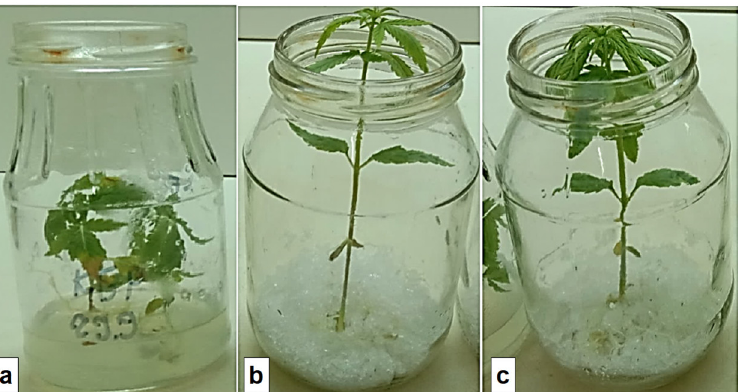
Figure 5. Visualization of the first cultivation cycle of Cánnabis satíva (14 days) on: ( a ) agar substrate; ( b ) polyacrylamide (PAAG); and ( c ) polyacrylamide substrate with the addition of amber (PAAG-A2). Each vessel contained one plant.